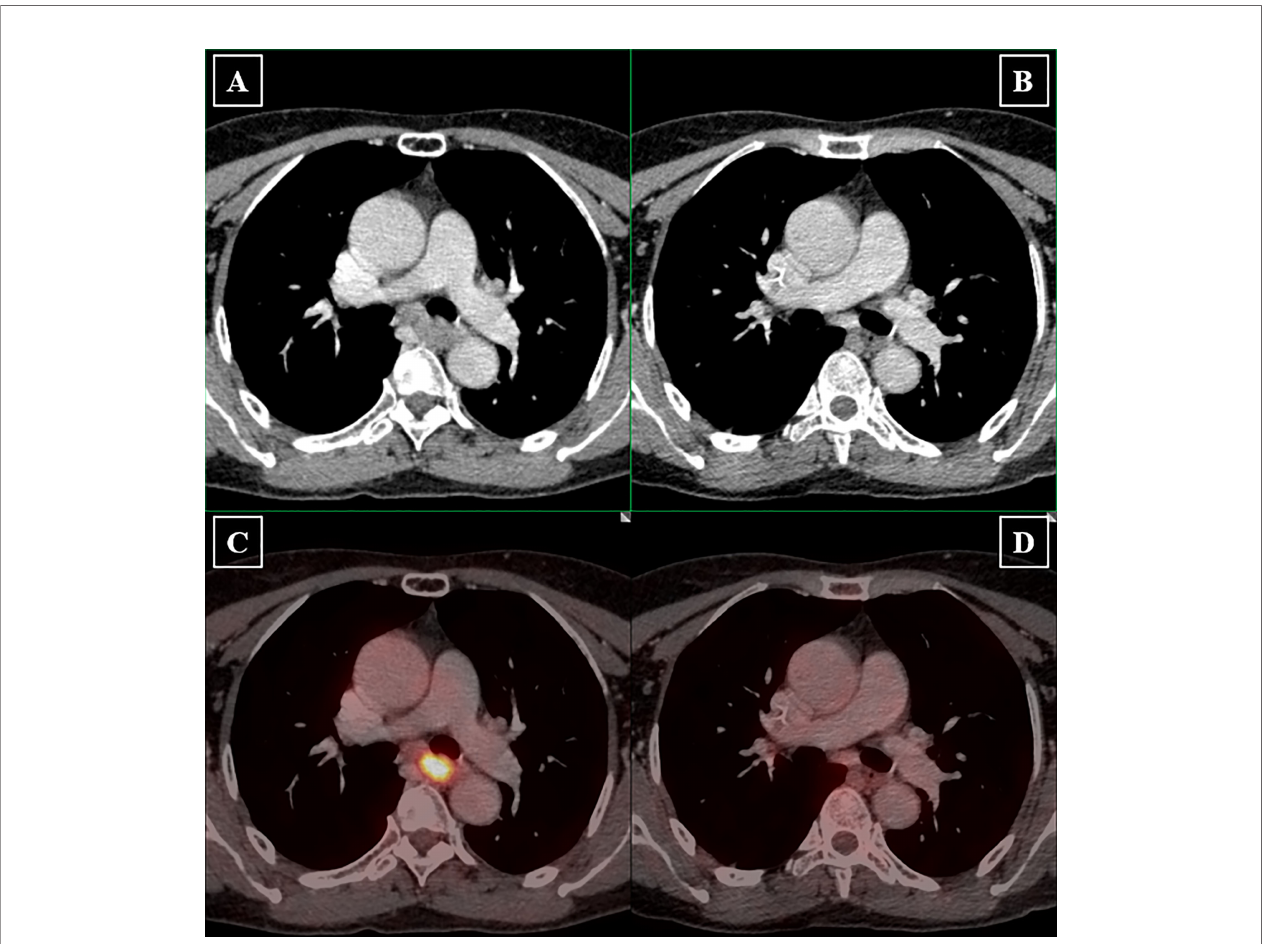
FIGURE 2 | Radiological assessment before and after induction immunochemotherapy. Longest diameters in the plane of measurement of primary lesions were recorded. Lymph nodes were considered malignant if the short axis is longer than 1.5 mm. Pretreatment clinical staging of primary tumor and lymph nodes were determined by both the physician in charge and radiologists. (A) Pretreatment PET-CT image shows that the primary tumor is large, irregular in shape with evident left bronchial compression. The normal esophageal lumen disappears due to extensive thickening of the esophageal wall. (B) Posttreatment PET-CT image shows that signi fi cant tumor shrinkage provides clear demarcation between primary tumor and the left bronchus. Esophageal lumen reappears. (C) Pretreatment PET-CT image presents hypermetabolic characteristic of the primary tumor. (D) Subsequent PET-CT image revealed tumor metabolic value reduced to background